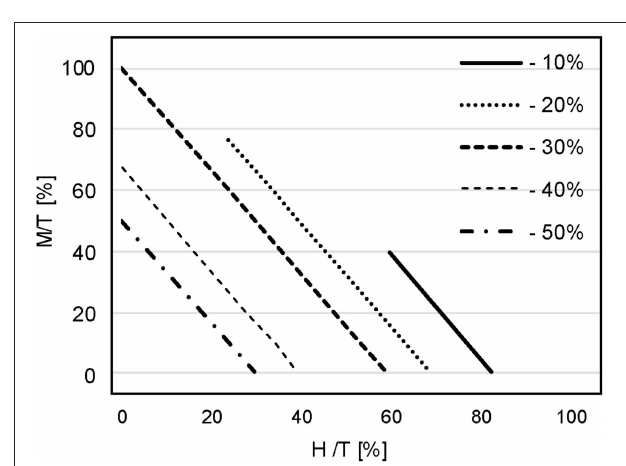
FIGURE 2 | Deviation of the peak heating load from the benchmark, depending on the fraction of H, M, and L in total population. Reproduced from Mahdavi et al. (2018) with permission from A. Mahdavi, M. Taheri, and F. Tahmasebi.